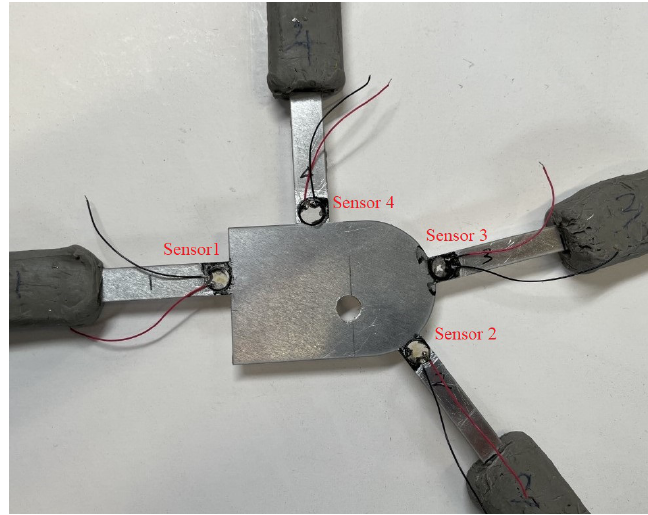
Figure 3. The aluminium joint with surface mount transducers and damage; there are four transducers in total, with the No. 1 transducer used to excite the signal, that is Sensor 1. The other sensors are used to receive the signal, named Sensor 2, 3 and 4 respectively.